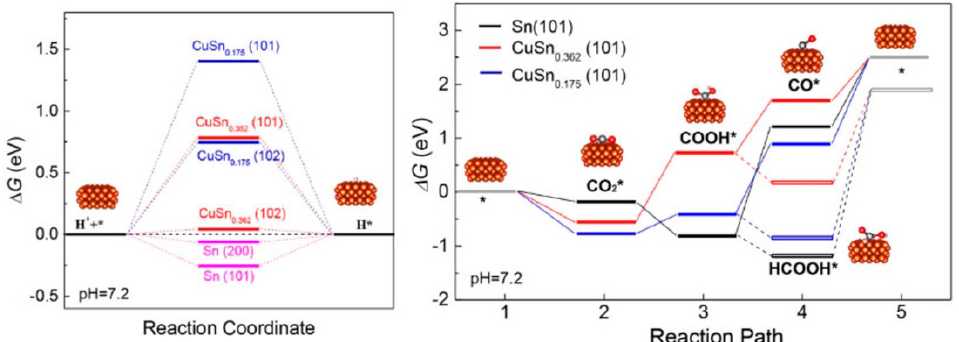
Figure 10. Left panel: Schematic Gibbs free energy profile for the H adsorption on different surfaces. Right panel: schematic Gibbs free energy profile for the detailed CO 2 RR pathway on the surface (101) of three models. Reproduced with permission [34].